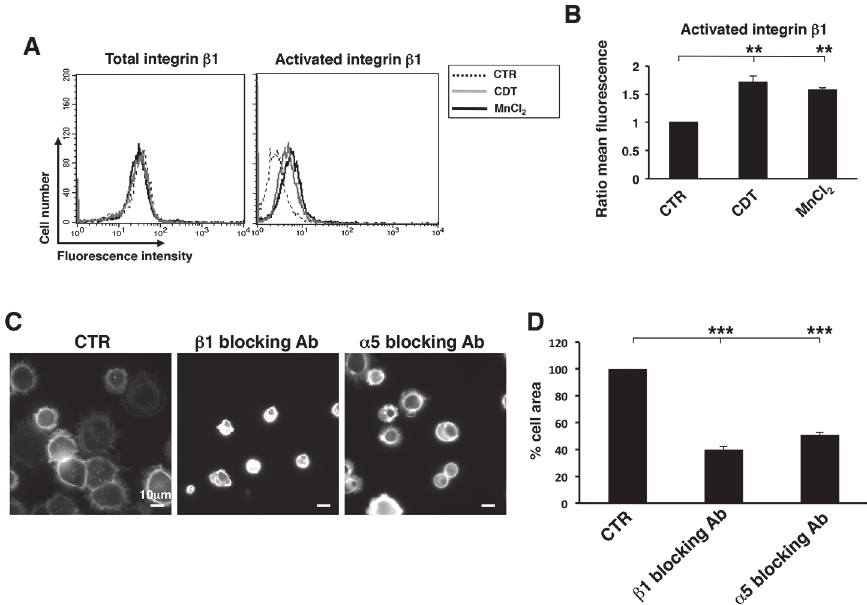
Fig 4. CDT intoxication promotes activation of β 1 integrin. A. HeLa cells were seeded, and further left untreated (dotted line), intoxicated with CDT (1 μ g/ml, grey line) for 6h, or treated with 2 mM MnCl 2 as described in Material and Methods (black line). Expression of the integrin β 1 total levels (left panel) or its activate form (right panel) was assessed by FACS analysis. B. Quantification of the activated form of integrin β 1. The data are presented as ratio between the mean fluorescence intensity of the intoxicated or MnCl treated cells and the mean fluorescence intensity of the untreated cells. Mean ± SEM of 5 independent experiments. Statistical analysis was performed using the Student t-test. ** p value < 0.01. C. Cell adhesion/ spreading assay was performed on HeLa cells left untreated or intoxicated with CDT for 6h prior detachment with 2.5 mM EDTA in PBS. Before adhesion on fibronectin-coated glasses, cells were incubated for 30 minutes with the rat monoclonal antibody 13 directed against integrin β 1 or mouse monoclonal antibody P1D6 directed against integrin α 5. As control, cells were incubated with normal rat or mouse serum (CTR). The figure shows representative micrographs where the actin cytoskeleton is visualized by phalloidin staining. D. Quantification of the cell spread was performed as described in Fig 1. Data are presented as percentage of the cell area relative to the cells pre-incubated with the normal rat or mouse serum. Mean ± SEM of three independent experiments. Statistical analysis was performed using the Student t-test. *** p value < 0.001.